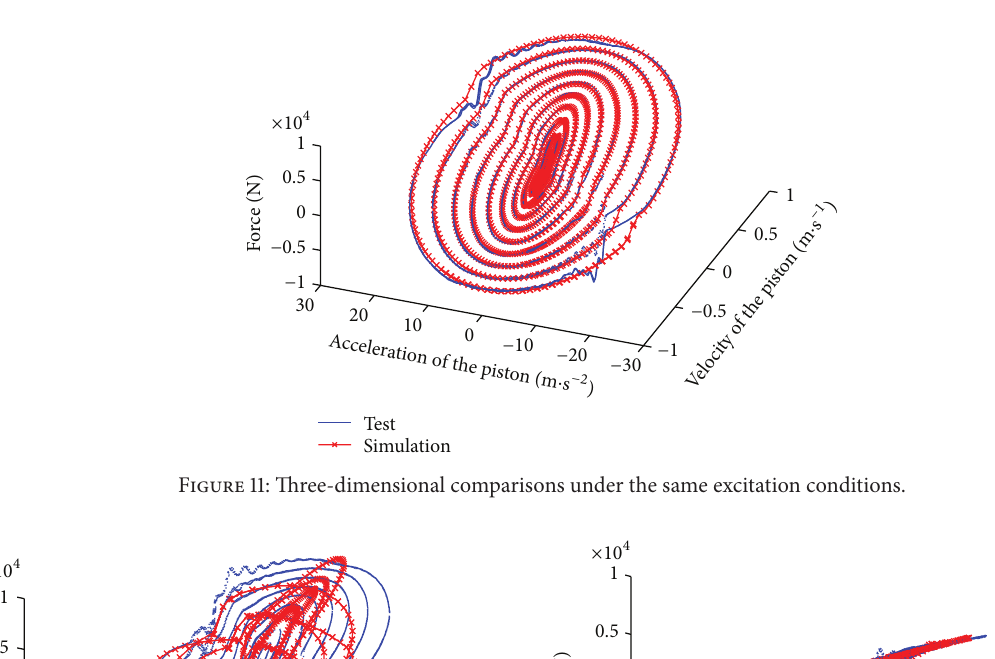
Figure 10: Comparisons while the amplitude of displacement is (a) 34 mm and (b) 17mm.